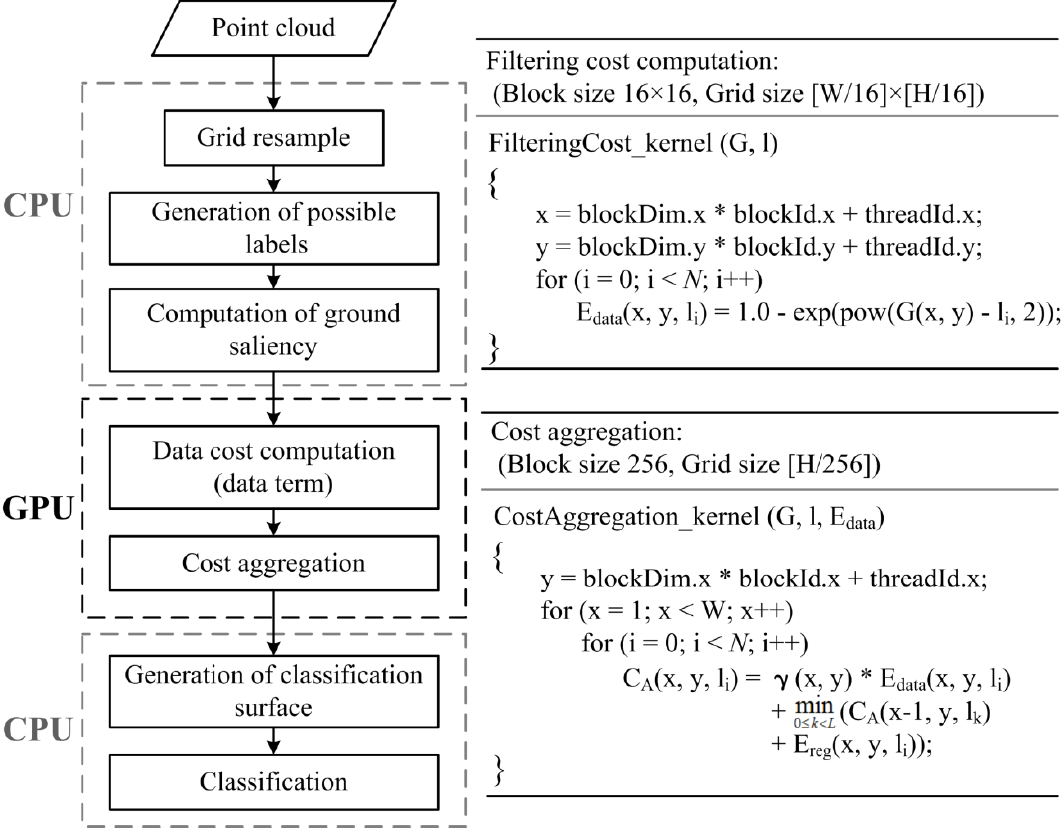
Figure 8. ( Left ) workflow of GPU acceleration, ( right ) implementation of the GPU